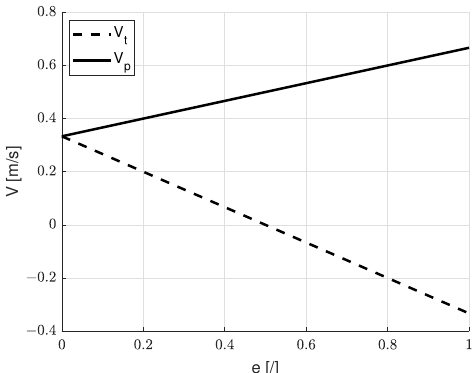
Figure 2. Influence of e on the end velocities of the tool and of the